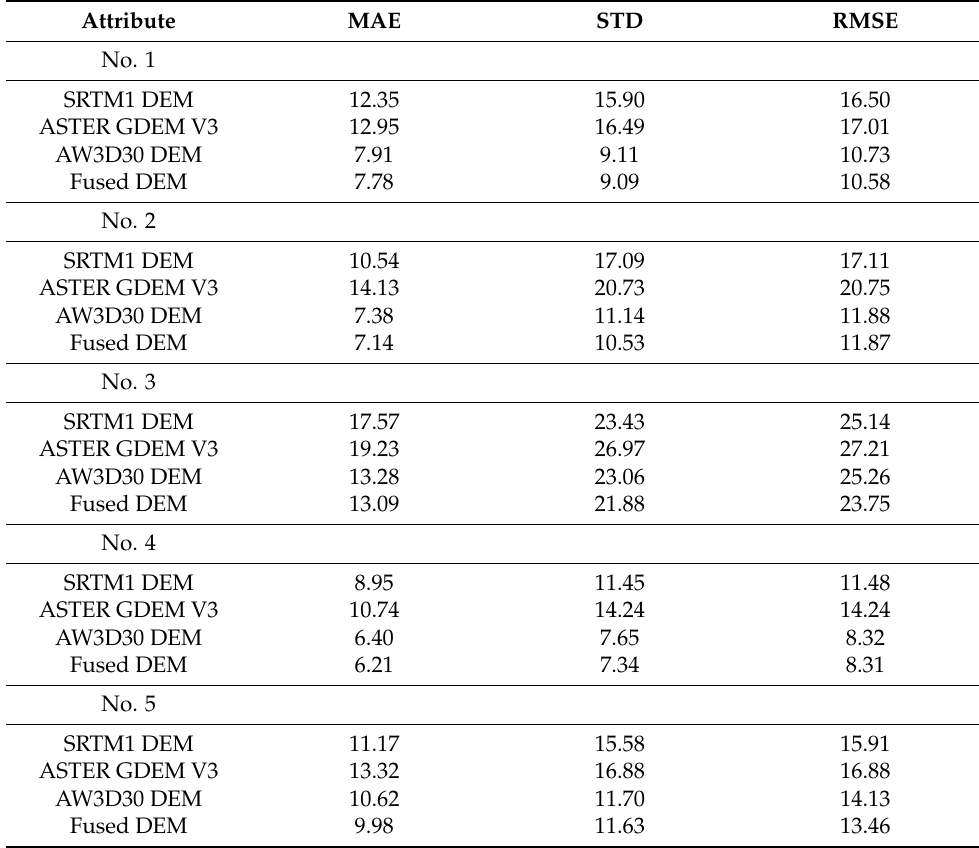
Figure 10. Elevation differences in complex mountainous validation areas. Table 5. Errors between SRTM1, ASTER GDEM V3, AW3D30, Fused DEM, and reference DEM in complex mountain validation